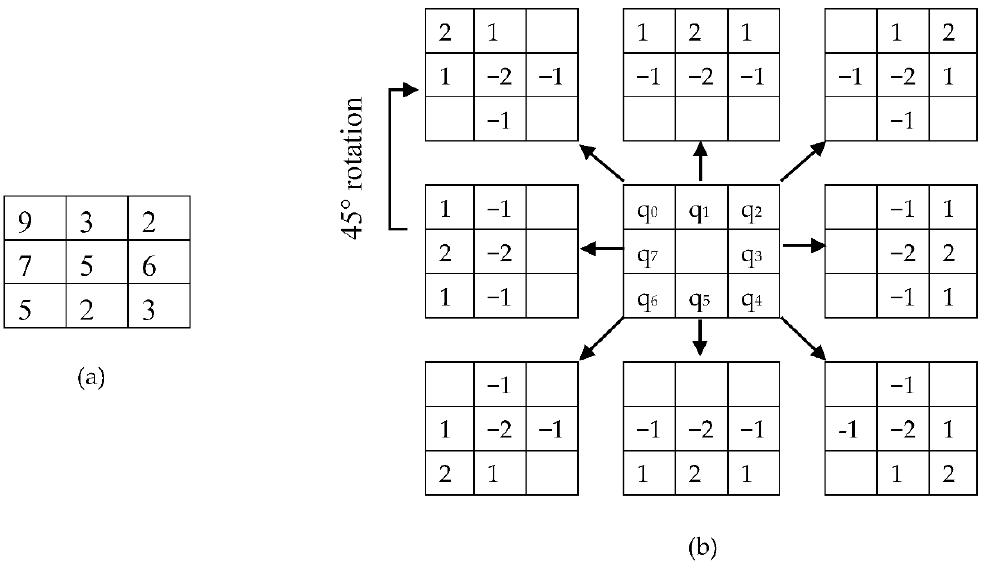
Figure 6. ( a ) Sample image segment of 3 × 3, ( b ) Description of Local Binary Pattern (LBP) (8, 1) : kernel value.